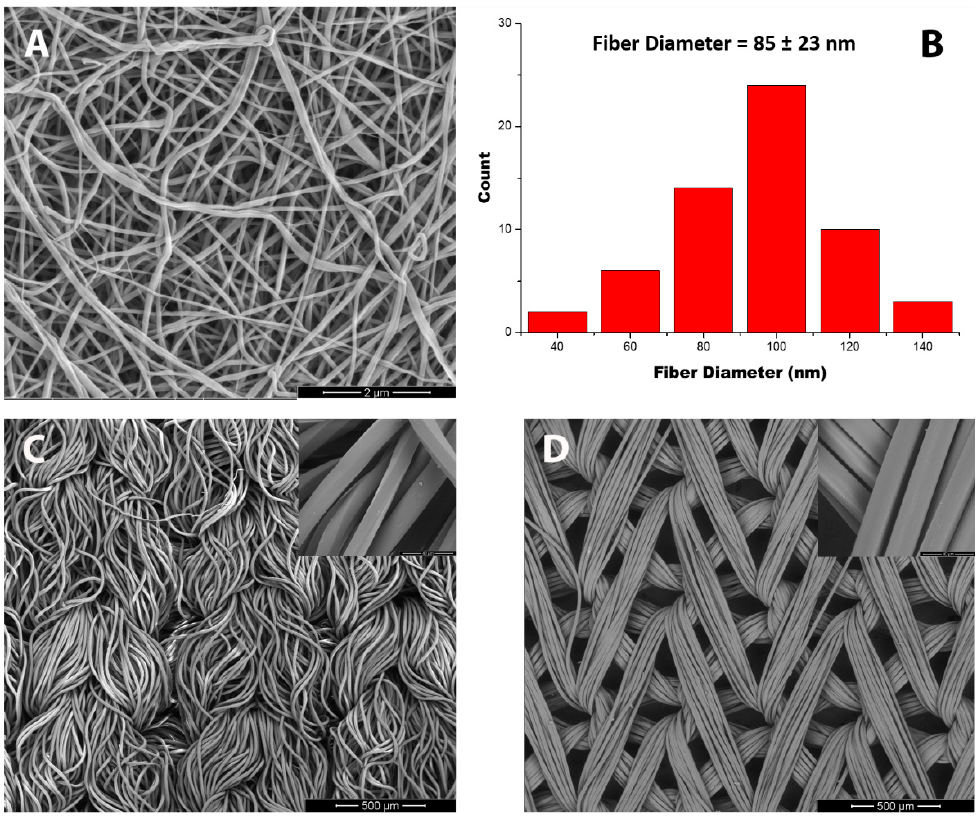
Figure 1. FE-SEM imaging of ( A ) nylon 6 nanofibers (ES_N6); ( B ) Fiber diameter distribution of ES_N6, ( C ) nylon 66 knit (K_N66), and ( D ) nylon 6 tricot (T_N6).